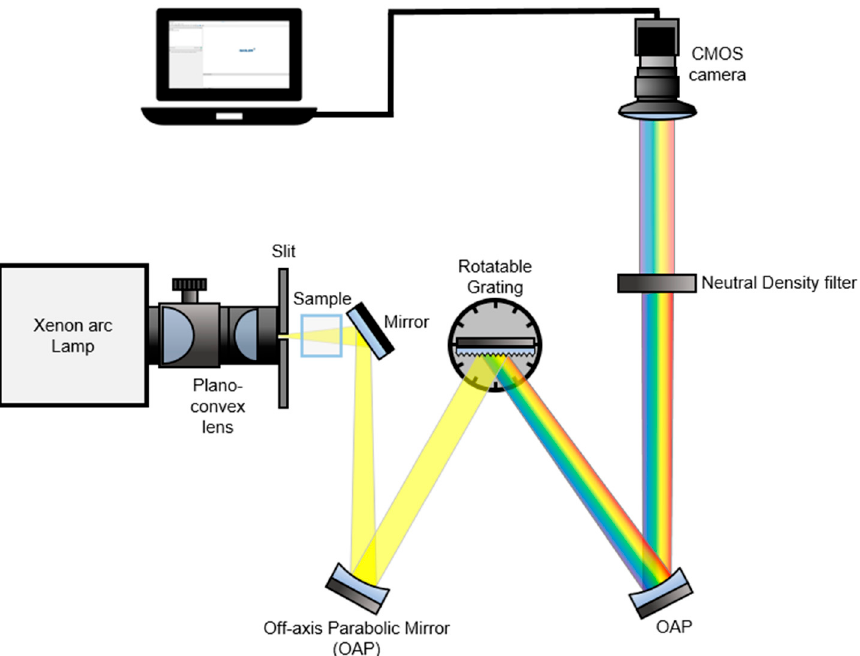
Figure 1. A schematic of the real-time UV/VIS spectroscopy setup. Broadband “white” light having a UV to NIR wavelength range was used as an illumination source. The light beam passed through a sample is collimated by an off-axis parabolic mirror (OAP) and it illuminates a grating. The dispersive spectrum is recollimated and passed through a neutral density (ND) filter (1.0 optical density, 10% transmission). A dispersed broadband signal is captured by a CMOS camera.